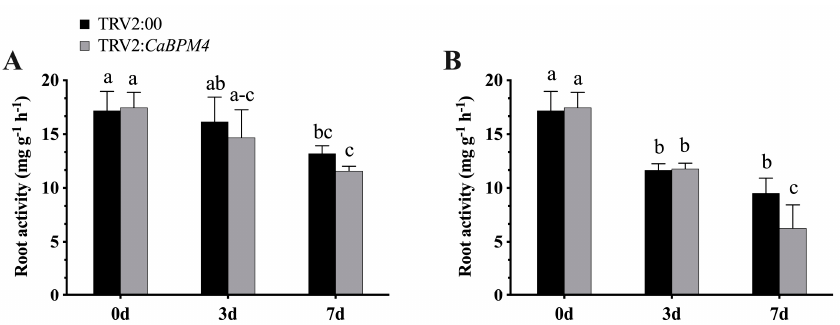
Figure 8. Silencing of CaBPM4 reduced the root activity of pepper post P. capsici inoculation. The root activity parameter showed that the activeness and function of roots. ( A ) Root activity in CaBPM4 -silenced and control plants after inoculation with the PC strain; ( B ) root activity in CaBPM4 -silenced and control plants after inoculation with the HX-9 strain. Values are the means ± SD from three independent experiments. Small letters (a–c) represent significant differences ( p < 0.05).